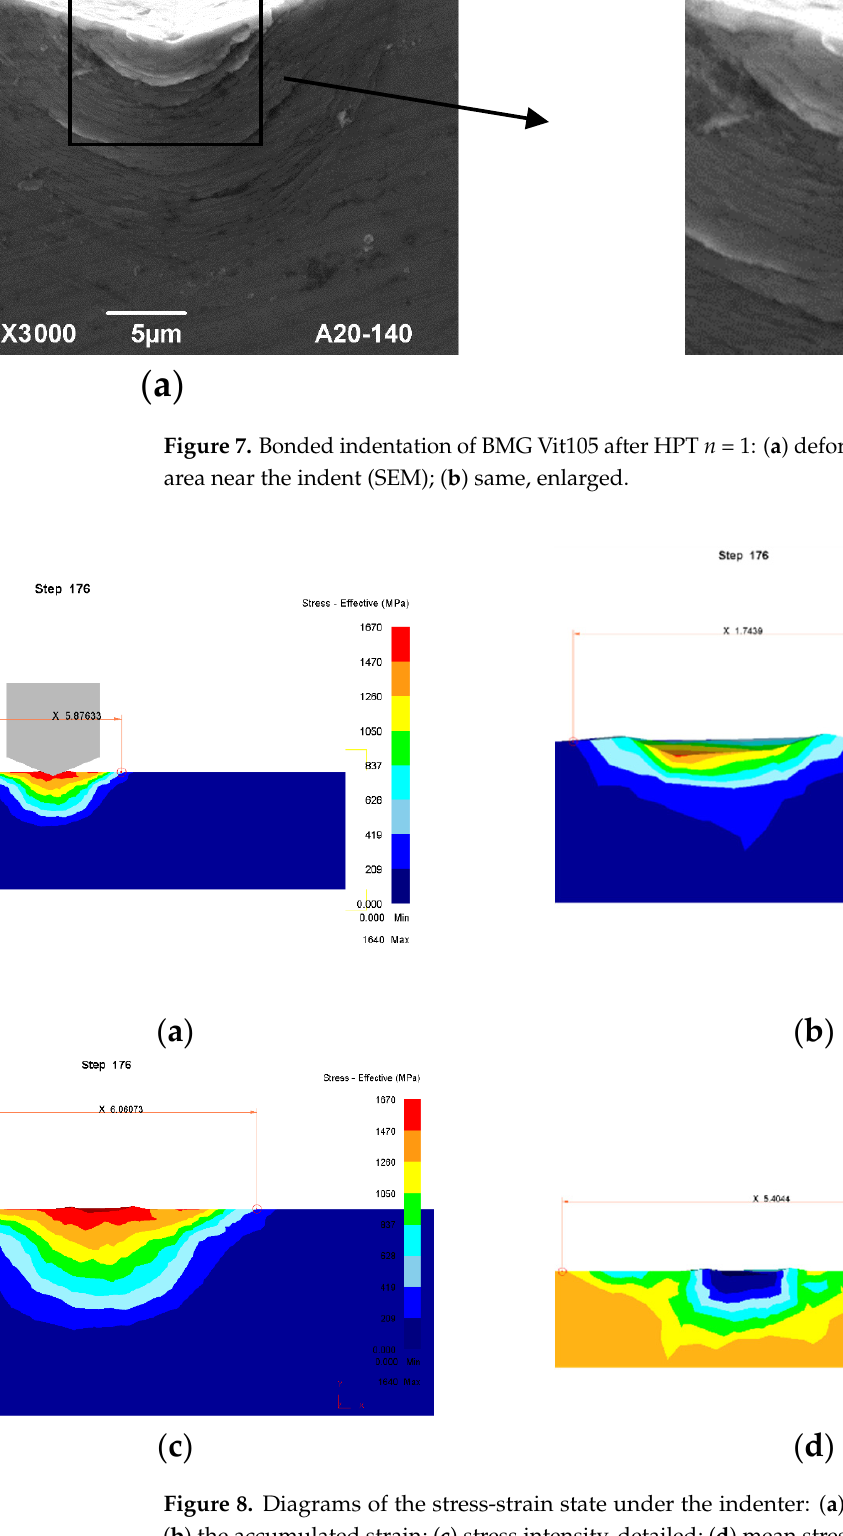
( d ) Figure 8. Diagrams of the stress-strain state under the indenter: ( a ) stress intensity, general view; ( b ) the accumulated strain; ( c ) stress intensity, detailed; ( d ) mean stress (hydrostatic pressure) values are negative, according to the theory of metal forming for compressive stress). 4. Discussion As previously mentioned, SBs are the main carriers of deformation in amorphous materials. In the initial state, BMG has a certain margin of uniformly distributed free vol- ume and, when under load, SBs are formed quite easily and the pattern of formation of SBs corresponds to the stress pattern and strain distribution generated from simulation data. A feature of the samples after HPT (Figure 7) is the heterogeneity of the pattern— there are main intense and less intense bands between them. The nature of the formation of such a pattern requires a more detailed study, presumably because the amorphous structure after HPT becomes much more heterogeneous. Hence, there is a large spread of